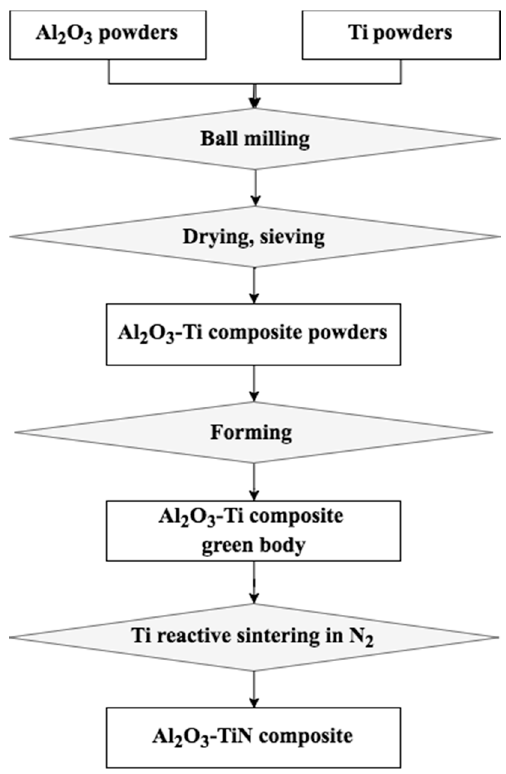
Figure 1. Flowchart of the fabrication process of Al 2 O 3 –TiN composites.